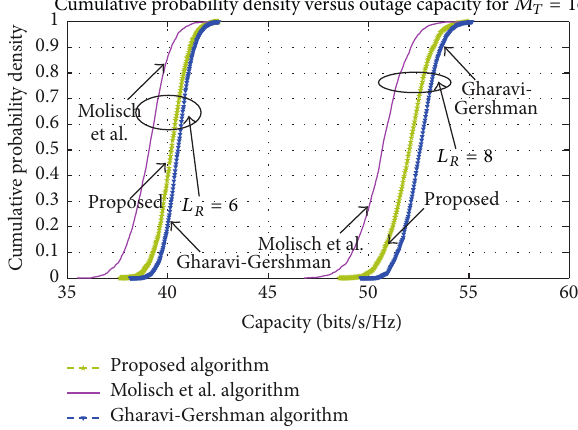
Figure 3: Plots showing the variation of outage capacity with number of selected antennas for 𝑀 𝑇 = 𝑀 𝑅 = 8 under i.i.d. channel condition.